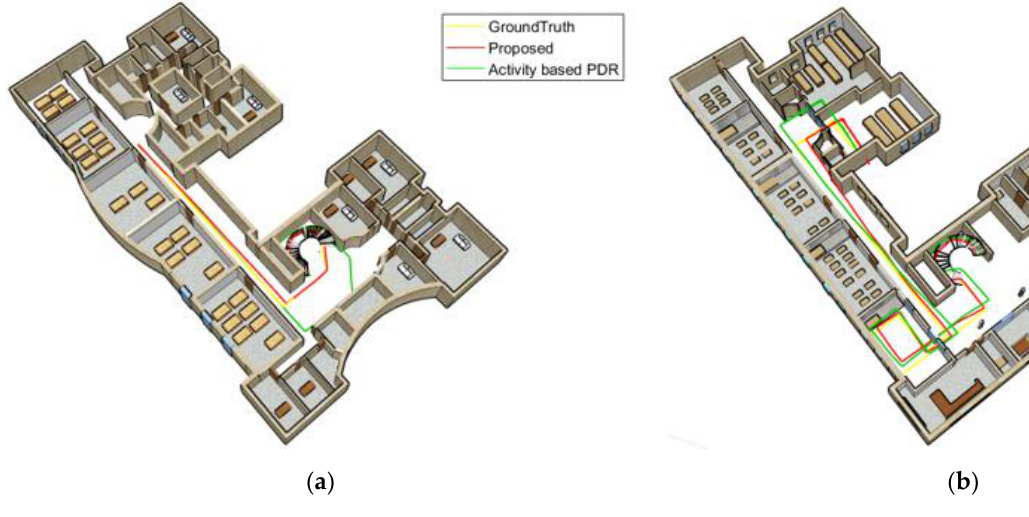
Figure 19. Texting man; ( a ) the third floor; ( b ) the first floor.